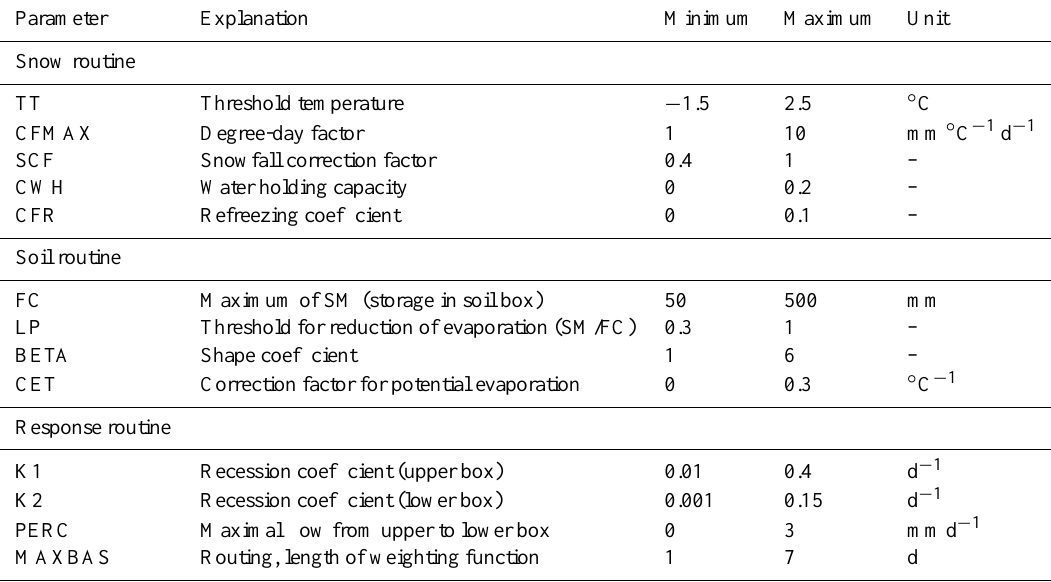
Table A3. Model parameters and their ranges to be used in the exercise. Parameter Explanation Minimum Maximum Unit Snow routine TT Threshold temperature Snowfall correction factor Water holding capacity